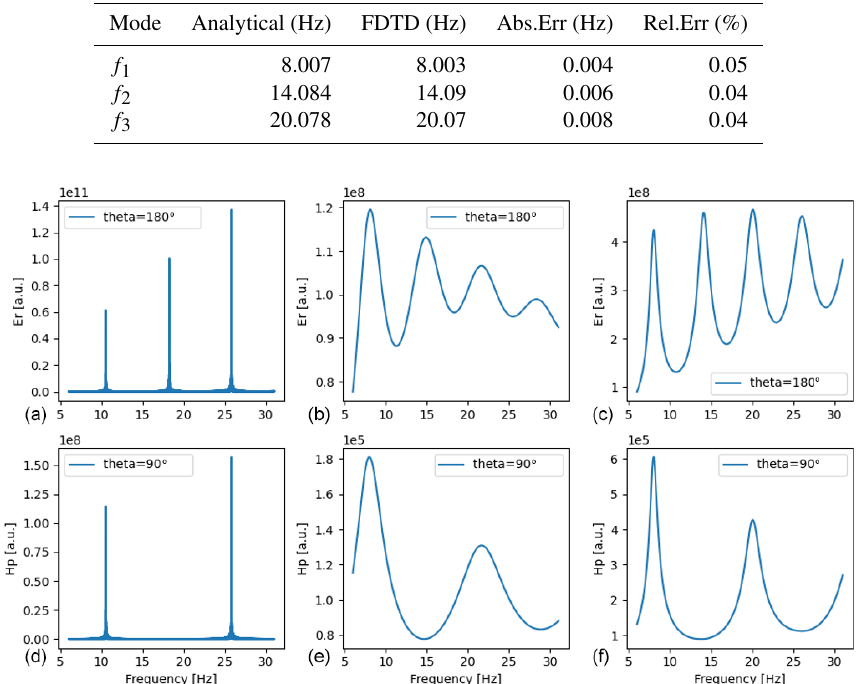
Table 3. Comparison of resonance frequencies obtained analytically and numerically for a two-layered spherical waveguide.